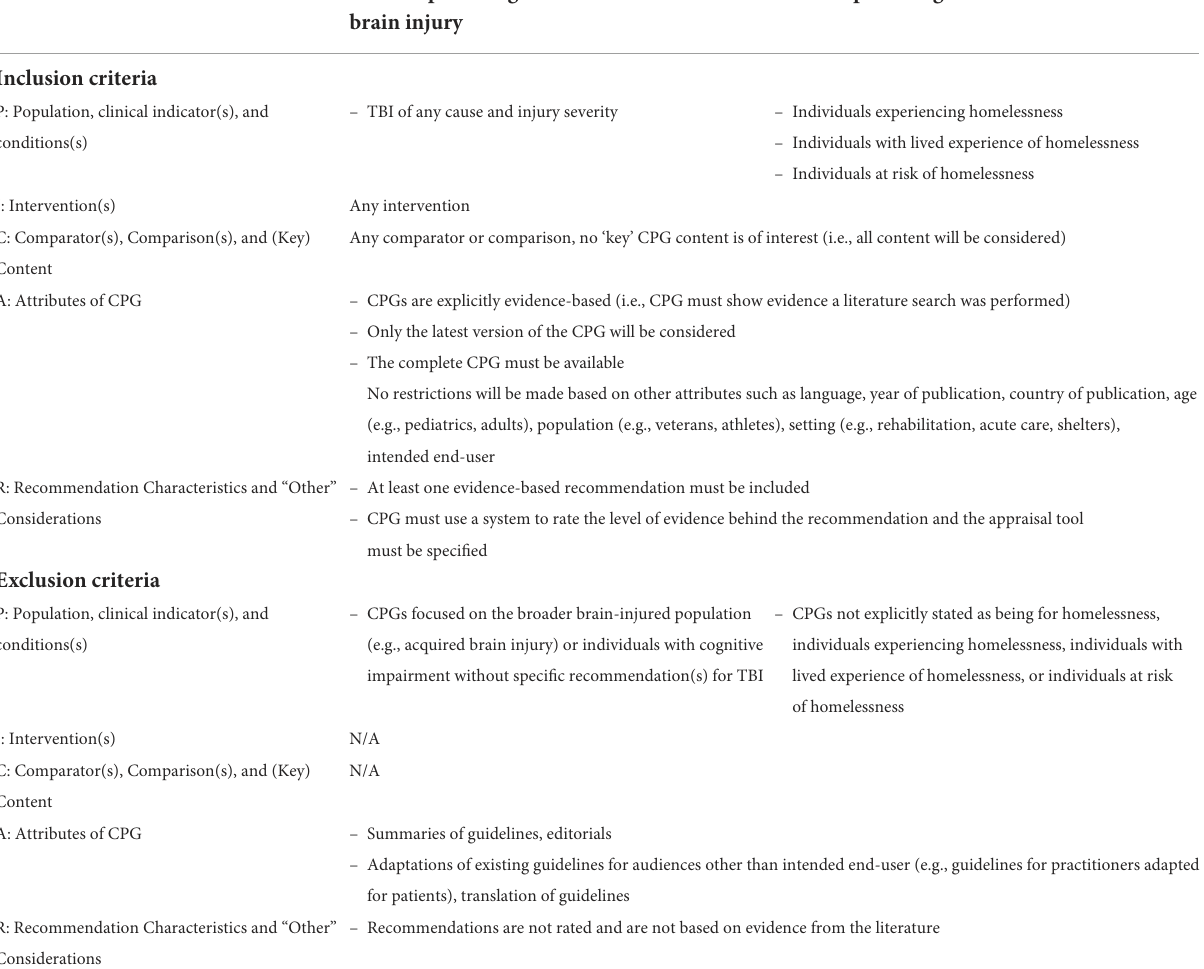
TABLE 1 PICAR statement for eligibility criteria. Clinical practice guidelines for